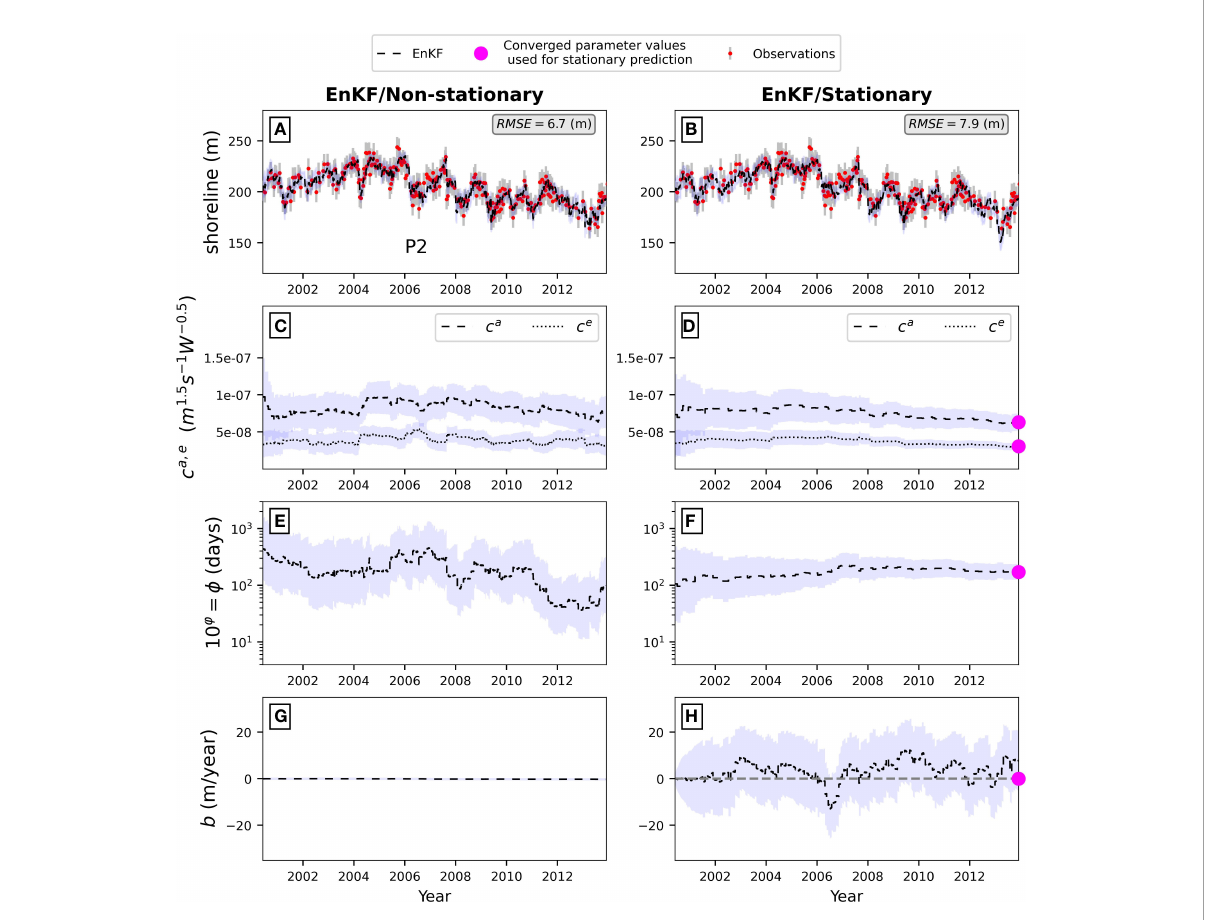
FIGURE 3 EnKF application to a multi-year (2000-2014) portion of the long-term dataset at the Gold Coast. Left and right panels show the non-stationary and stationary approaches, respectively. From top to bottom, each approach shows the shoreline observations and shoreline EnKF estimates (black line), c a and c e (dashed and dotted lines, respectively), f = 10 j and b. Blue bands indicate uncertainty, represented by the standard deviation of the ensemble ( n=500 ). Magenta dots in the right panels indicate the converged parameters used for predicting shoreline time series with a stationary